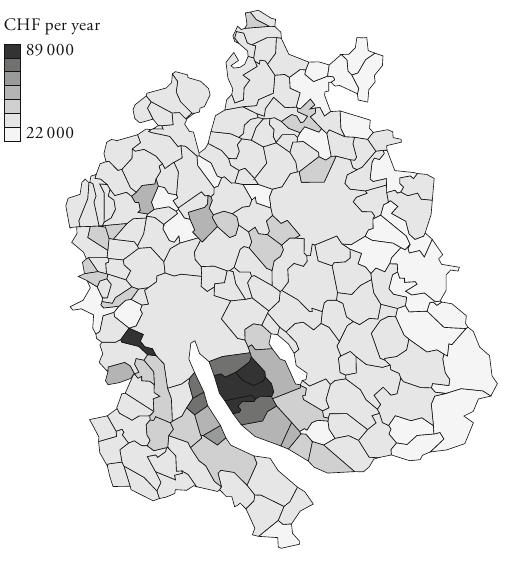
Figure 8: Taxable income per inhabitant across municipalities in the canton of Zurich in